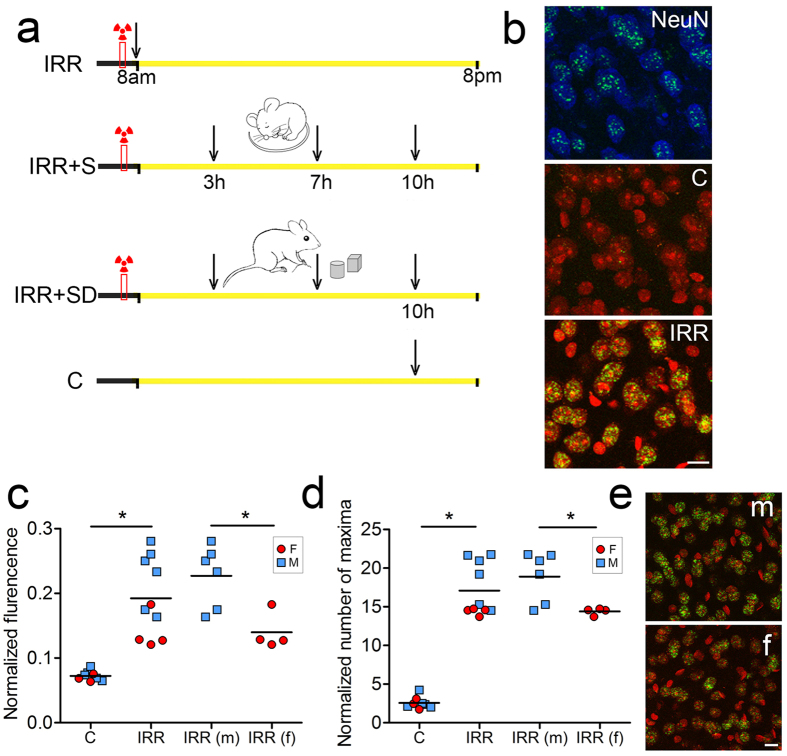
Effects of gamma-irradiation on DSBs in mouse frontal cortex.(a) Experimental design. The red box indicates the time when gamma-irradiation occurred, between 7 and 8 am, before light on. The yellow bar indicates the 12 h light period (8 am–8 pm). Vertical arrows show the time of brain collection. IRR, irradiation; S, sleep; SD, sleep deprivation; C, control. (b) Top panel: γH2AX positive foci (green) induced by gamma-irradiation were found primarily in neurons immunostained with the specific neuronal marker NeuN + (blue). Middle and bottom panels: representative images from the frontal cortex of a control mouse (C, middle panel) and a mouse killed within 1 hour post-irradiation (IRR, bottom panel). Scale bar = 10 μm. (c,d) Quantification of γH2AX normalized fluorescence and local maxima in C and IRR mice. Circle and square symbols indicate males and females, respectively. *p < 0.05 (e) Representative microscopic fields from the frontal cortex of a post γ-irradiated male (m) and a post γ-irradiated female (f) mouse showing the different number of γH2AX positive foci. Scale bar = 10 μm.